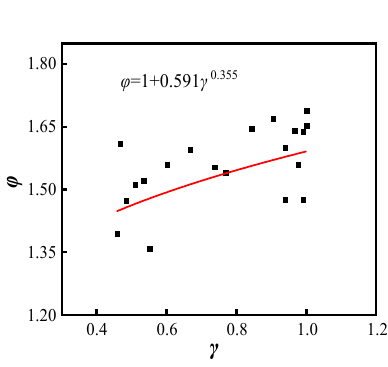
γ Figure 18. fitting pattern. Figure 18. γ fitting